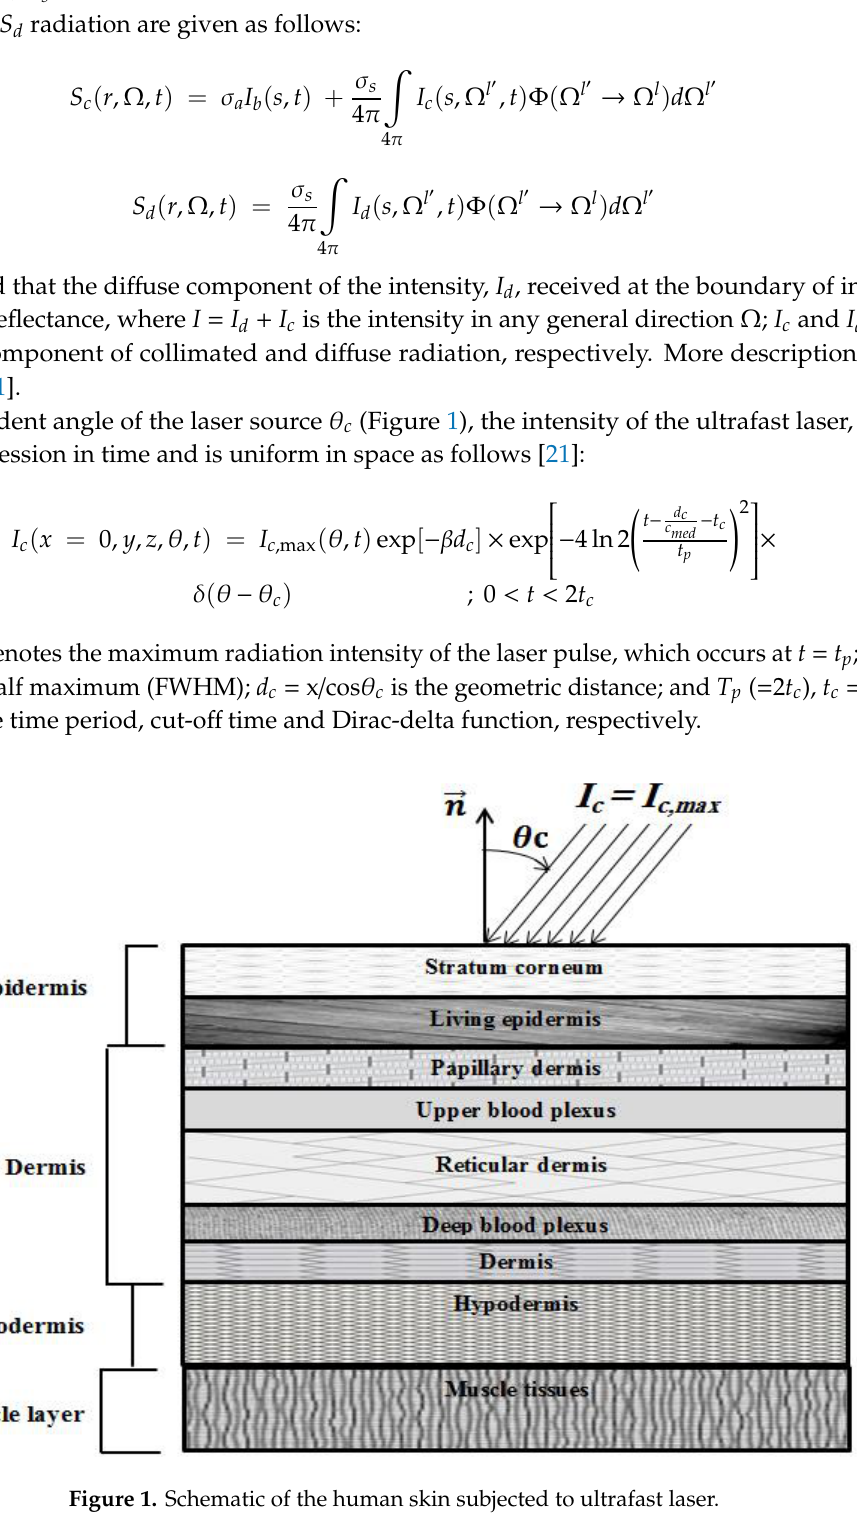
Figure 2. Schematic of the ultrafast laser’s interaction within the skin used in the simulation. The incident laser pulse I c (t) has a Gaussian’s profile, as plotted in Figure 3. Temporal deviations of transmittance and reflectance signals are examined for three-dimensional skins. All computations are done using 400 × 21 × 21 control volumes and 80 control angles (i.e., the FT8). Only the predictions of the CLAM scheme are analyzed. For all cases, a time step size ∆𝑡 = ∆𝑥 𝑛×𝑐 ≈ 9.5 ∙ 10 −3 ps has been applied, and thus this step size is much less than the pulse width (i.e., ( ∆𝑡 ≪ tp)). The incident angle of the ultrafast laser is taken as normal to the irradiated boundary (i.e., θ c = 0.0 °) (Figure 3). For all results, both transmittance and reflectance signals have been normalized according to their corresponding highest values in each corresponding case.